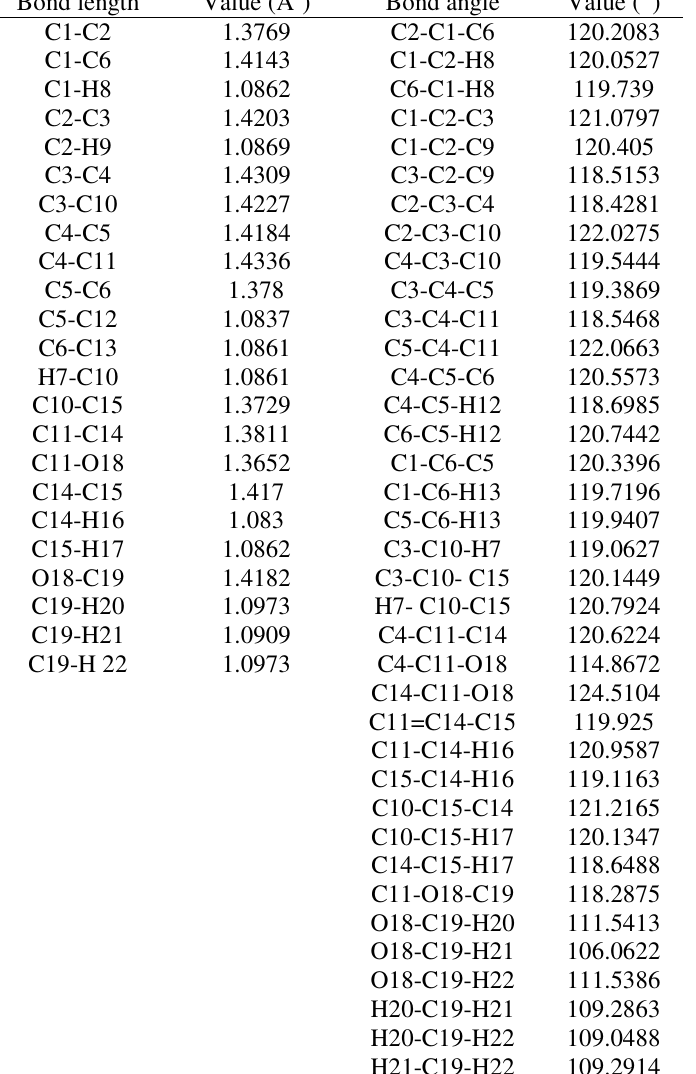
Table 1. Optimized parameters of 1-